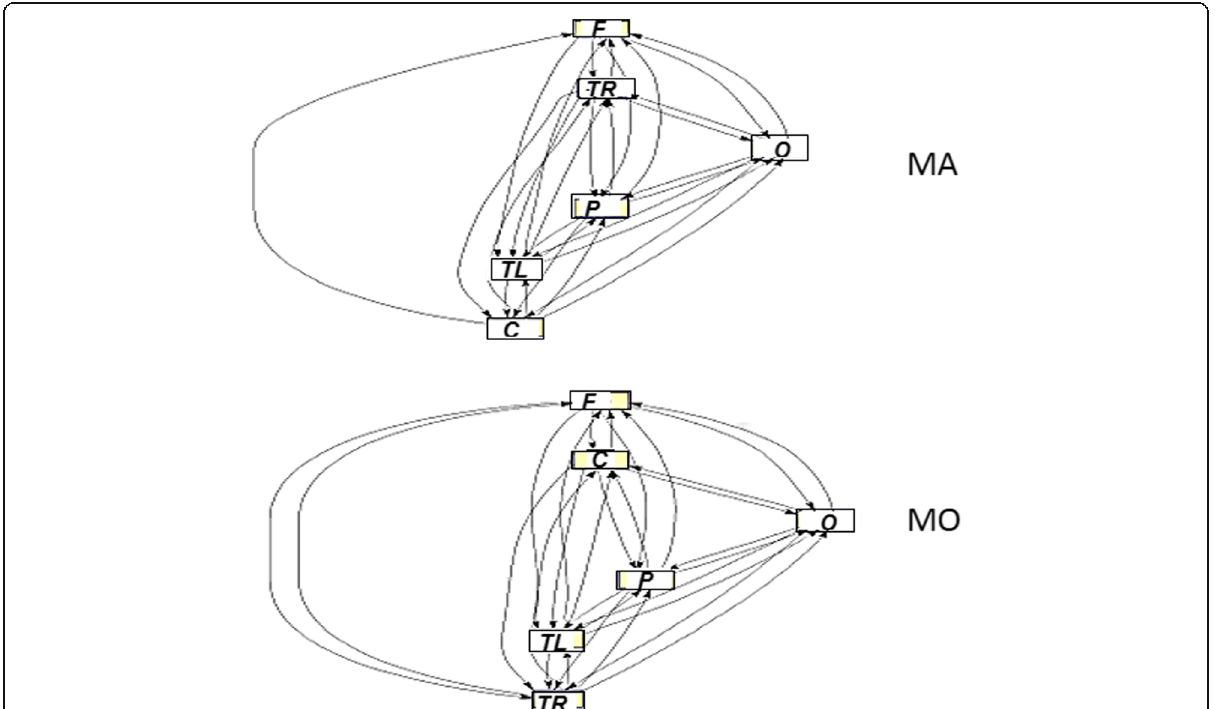
Fig. 8 Network diagrams for Migraine with aura (MA) and without aura (MO) for alpha band at 2 cpd stimulation. The by-pass role of the occipital area (O) in the MA in the anterior / posterior connection emerges. (further data on analysis are available in the Supplementary section, chapter 5.6.2) F: Frontal; C: Central; P: Parietal; RT: Right Temporal; LT: Left